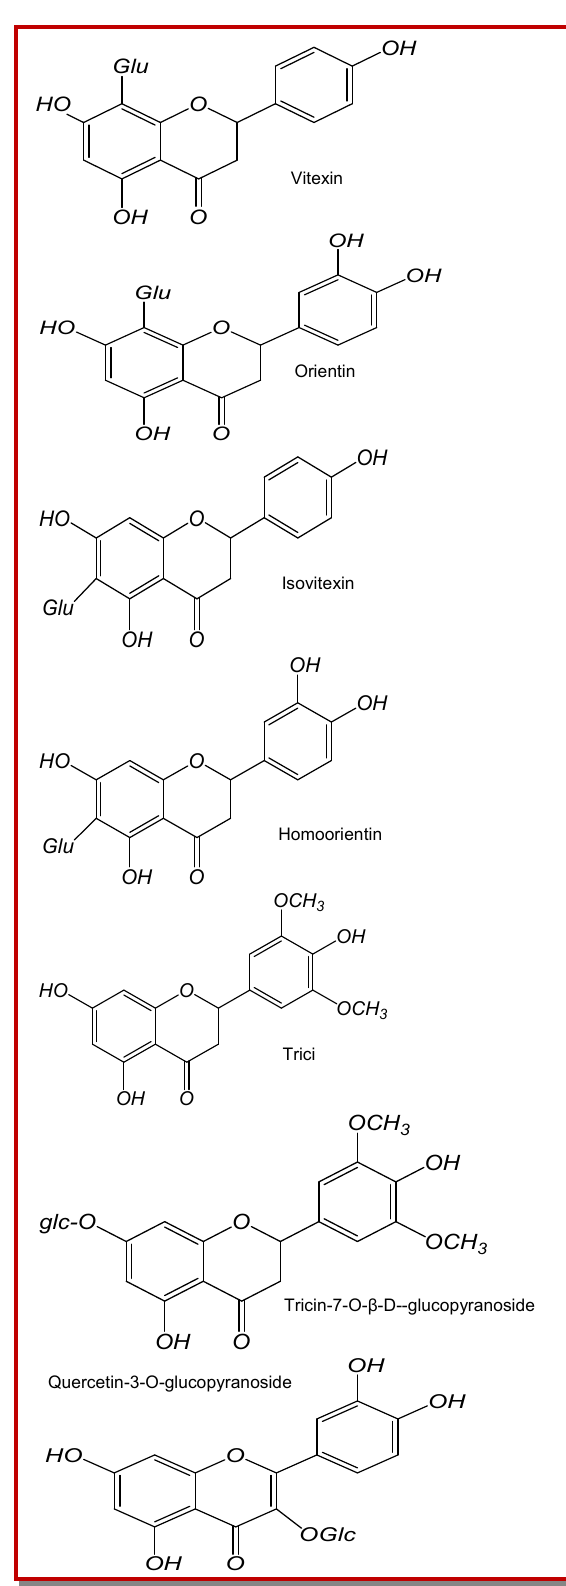
Figure 1: Structure of the